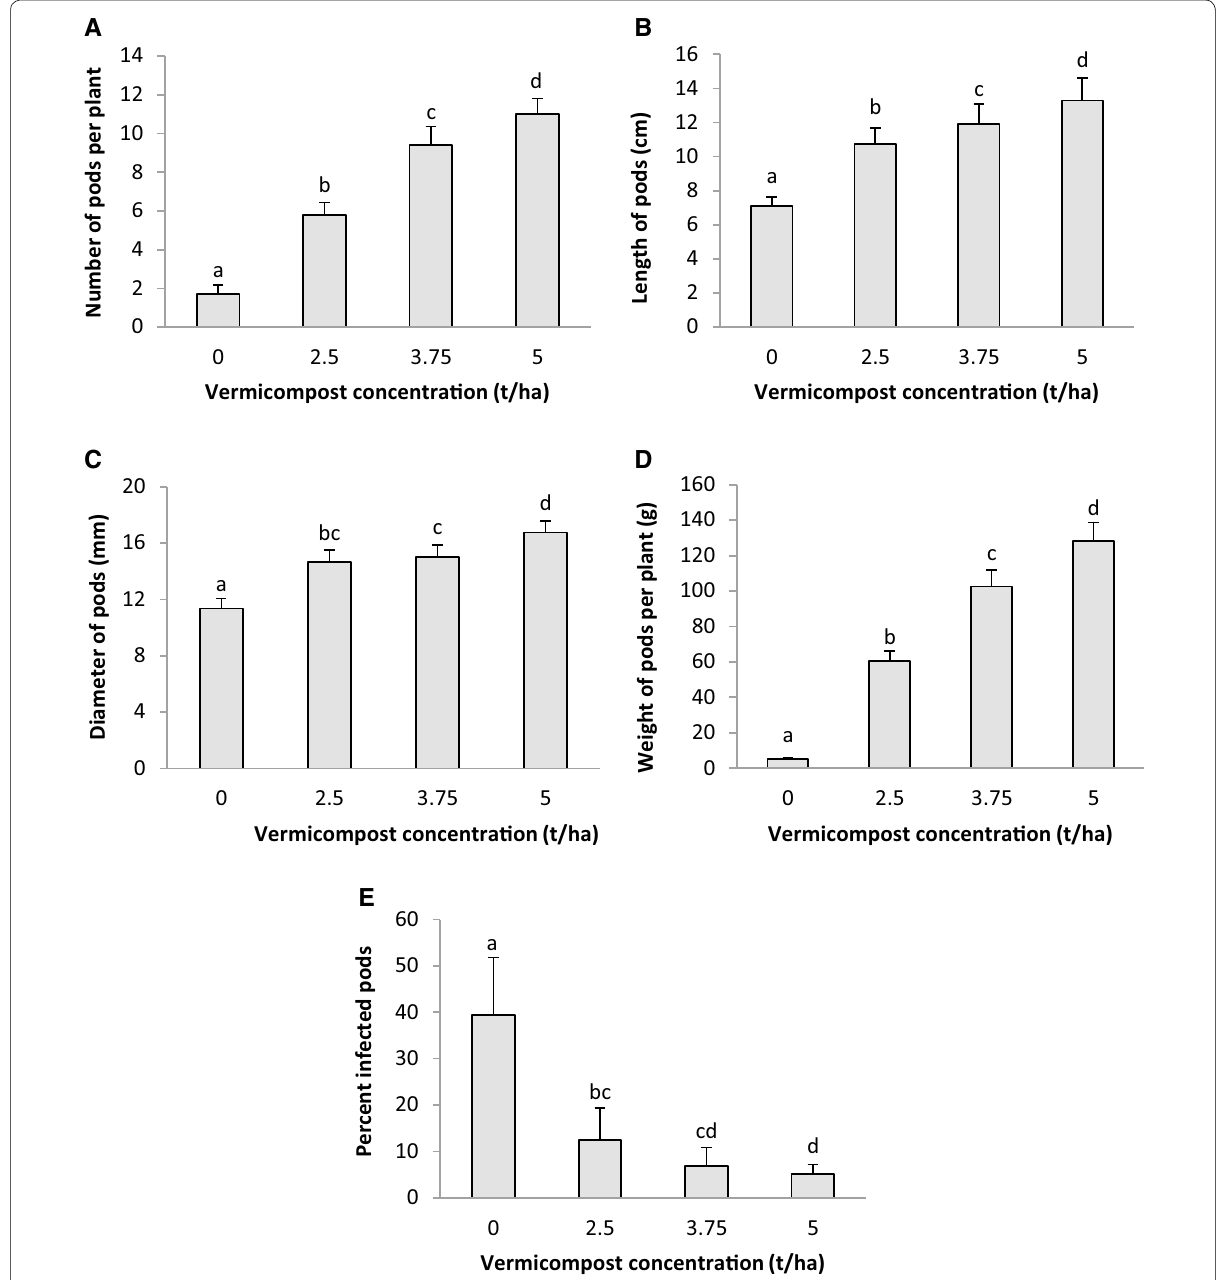
Fig. 1 Effect of parthenium vermicompost on A number of pods, B length of pods, C diameter of pods, D weight of pods per plant, and E weight of infected pods of ladies finger. The standard deviation is indicated on the chart. Results which do not differ significantly (LSD test; p < 0.05) carry at least one character in the superscript which is